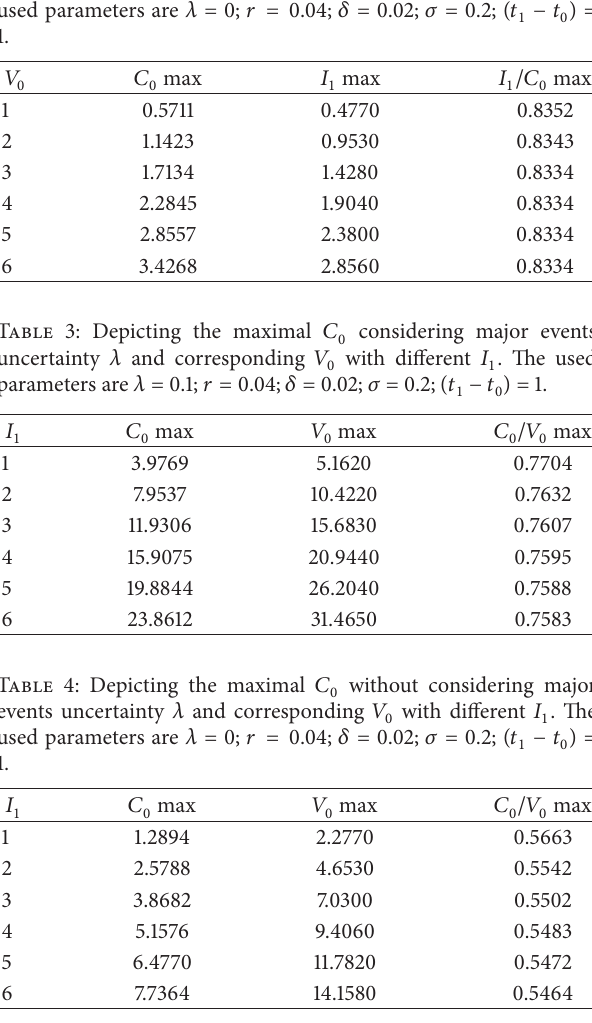
Table 2: Depicting the maximal 𝐶 0 without considering major events uncertainty 𝜆 and corresponding 𝐼 1 with different 𝑉 0 . The